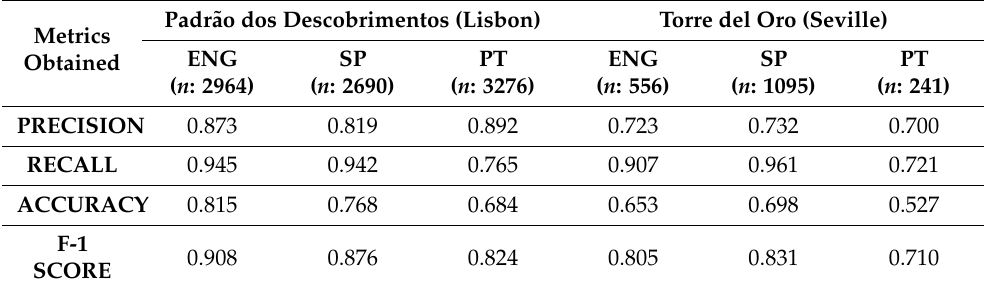
Table 6. Results obtained from 3 × 3 confusion